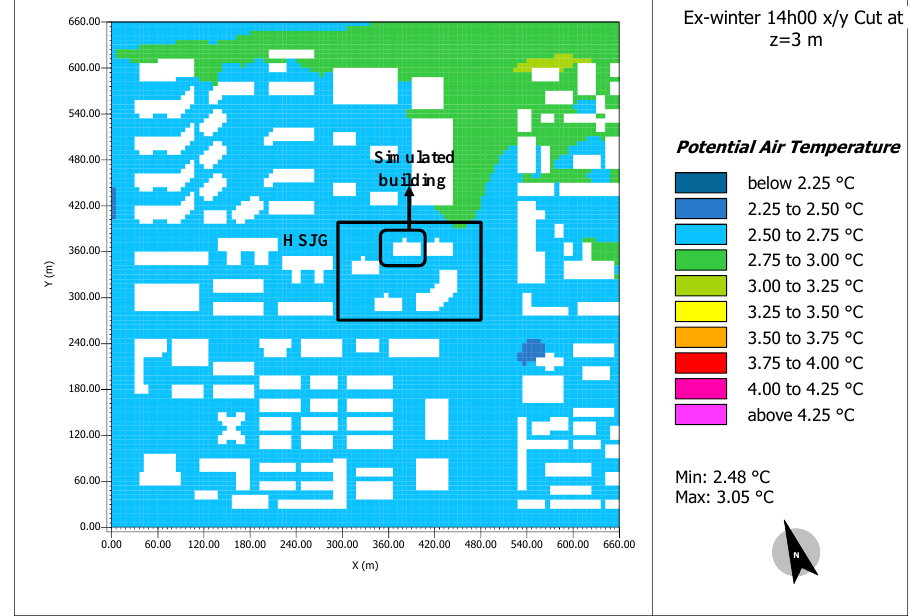
Figure 10. Potential temperature map of the simulated area for av-autumn at the height of 3 m.